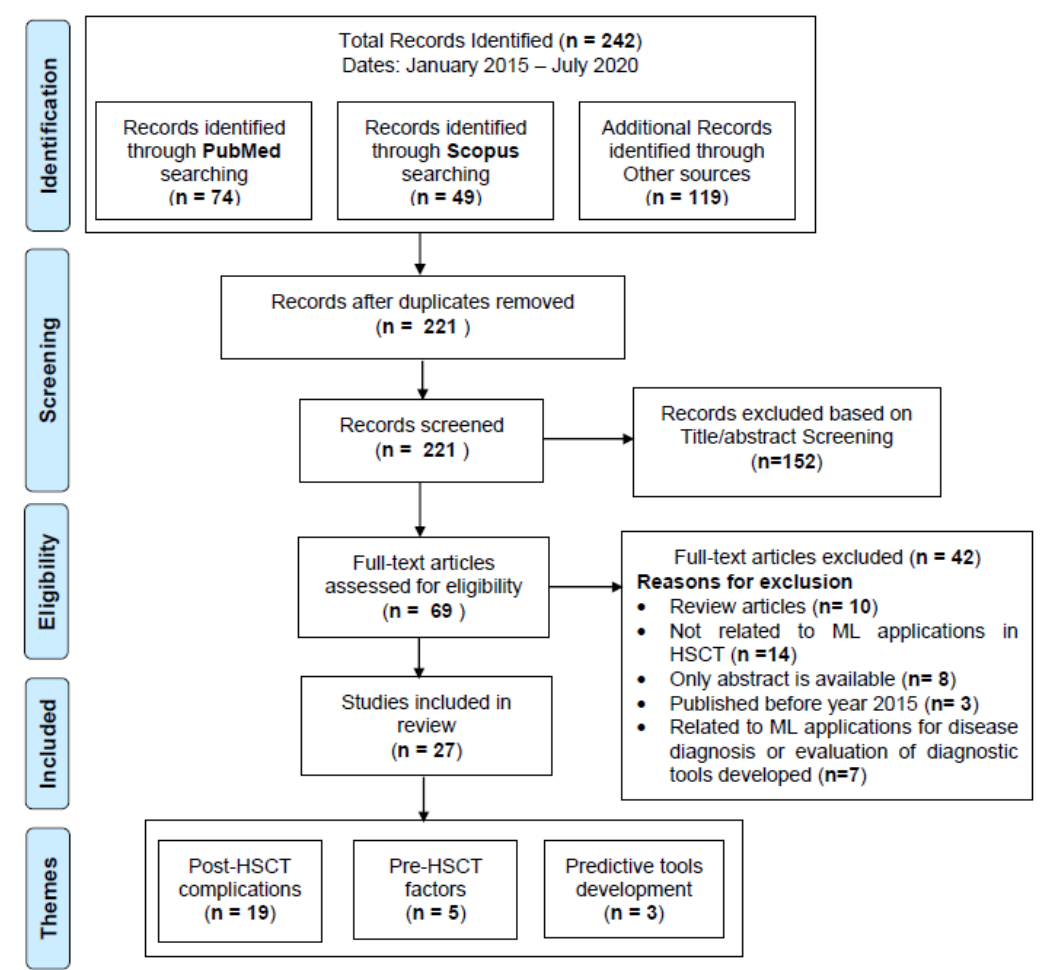
Figure 1. PRISMA Workflow for systematic identification of scientific literature.